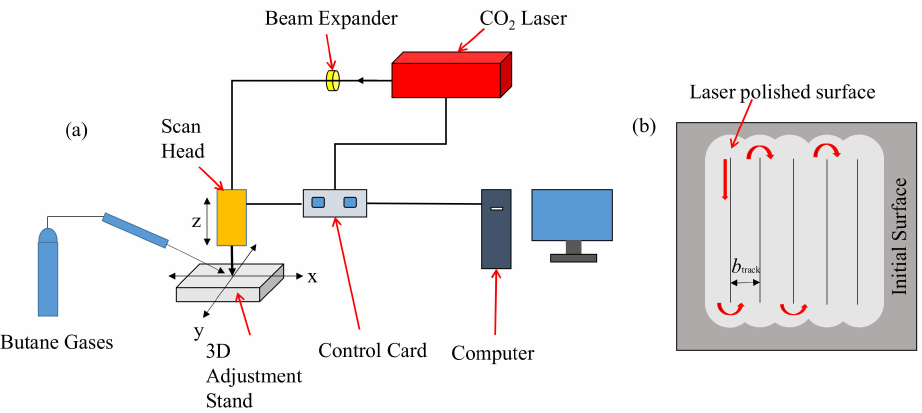
Figure 1. ( a ) Schematic diagram of laser polishing system. ( b ) Schematic diagram of scanning